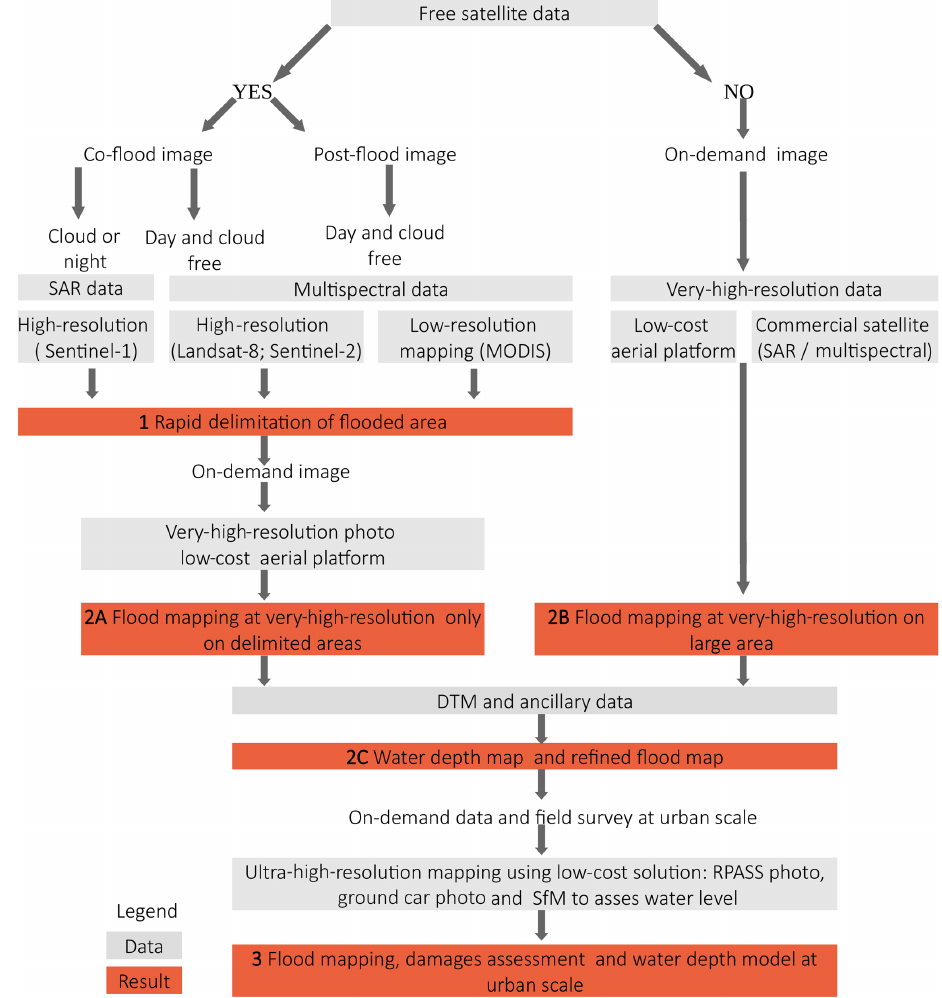
Figure 13. Flowchart of the proposed flood mapping